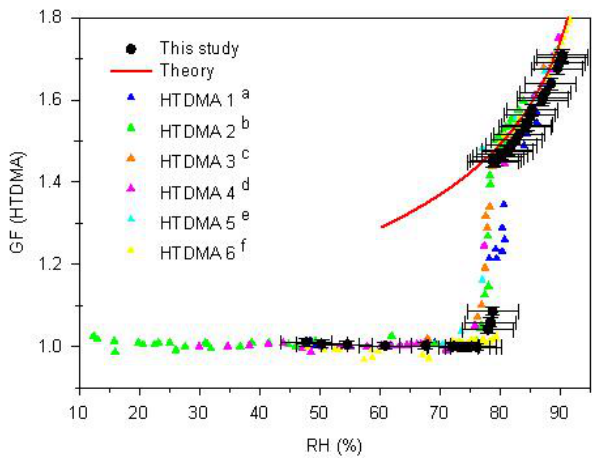
Fig. 7. Humidogram of 150nm ammonium sulfate particles show- ing the hygroscopic growth factor measured with the H-TDMA as a function of relative humidity (black circle). The solid red line de- scribed the theory from Biskos et al. (2006). Humidograms from Duplissy et al. (2009) were added for comparison (coloured trian-